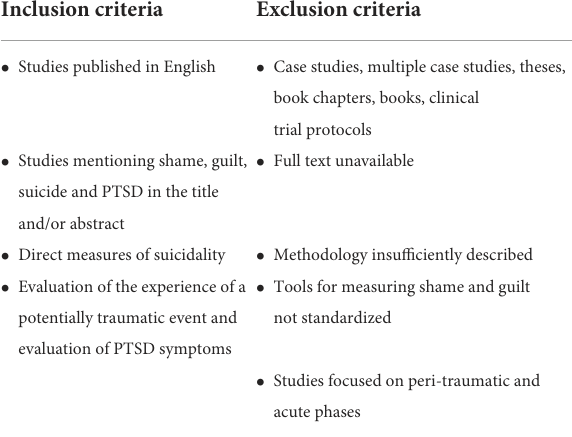
TABLE 1 Criteria of inclusion and